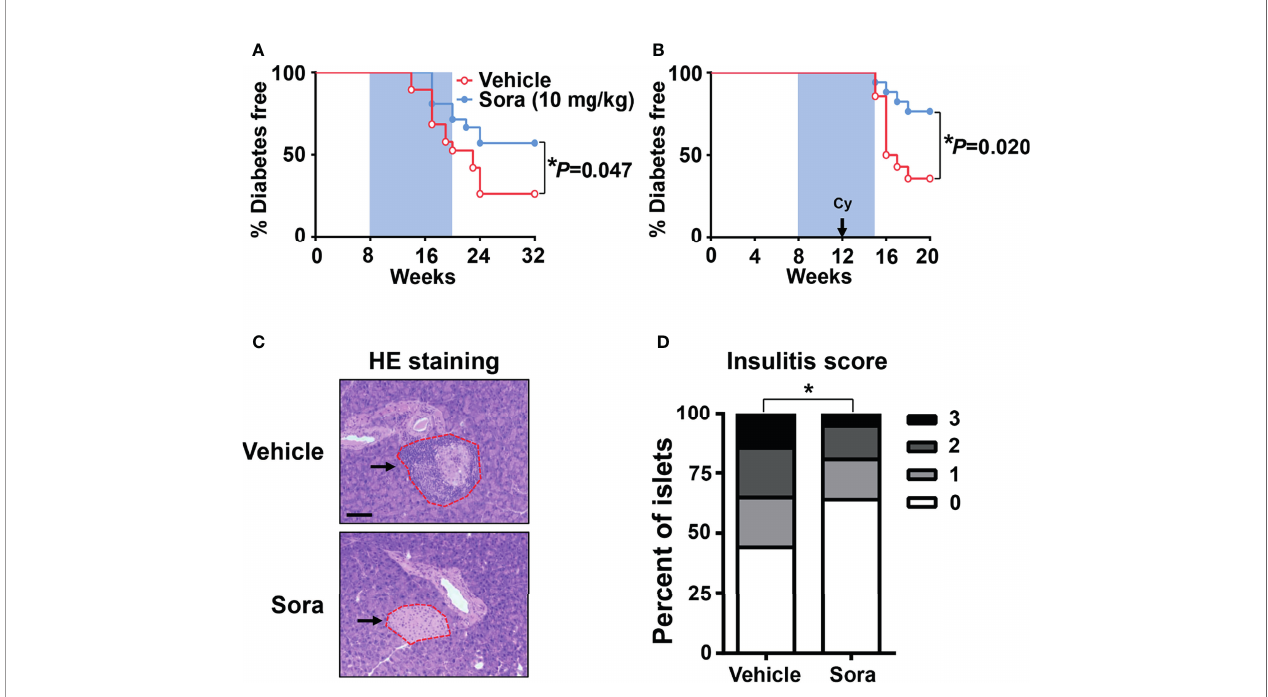
FIGURE 2 | Sorafenib prevents the development of autoimmune diabetes in NOD mice. (A) Diabetes incidence of female NOD mice having been treated (gavage) daily with vehicle (n = 19) or sorafenib (10 mg/kg, n = 21) for 12 weeks (blue shaded area). (B) Diabetes incidence of female NOD mice having been treated daily with vehicle (n = 14) or sorafenib (10 mg/kg, n = 17) for 7 weeks. Cyclophosphamide (Cy, 300 mg/kg) was injected i.p., 4 weeks after beginning of sorafenib treatment. Statistical signi fi cance: * P < 0.05 versus vehicle by long-rank test. (C) Representative images of HE staining for pancreatic sections from 14-week-old prediabetic NOD mice having been treated daily with sorafenib (10 mg/kg) or vehicle for 6 weeks, Cy (300 mg/kg) was injected i.p., 4 weeks after beginning of sorafenib treatment, the arrows point to the islet in pancreas. (scale bar indicates 100 m m). (D) Insulitis scores from 14-week-old prediabetic NOD mice, data are combined from two independent experiments. * P < 0.05, c 2